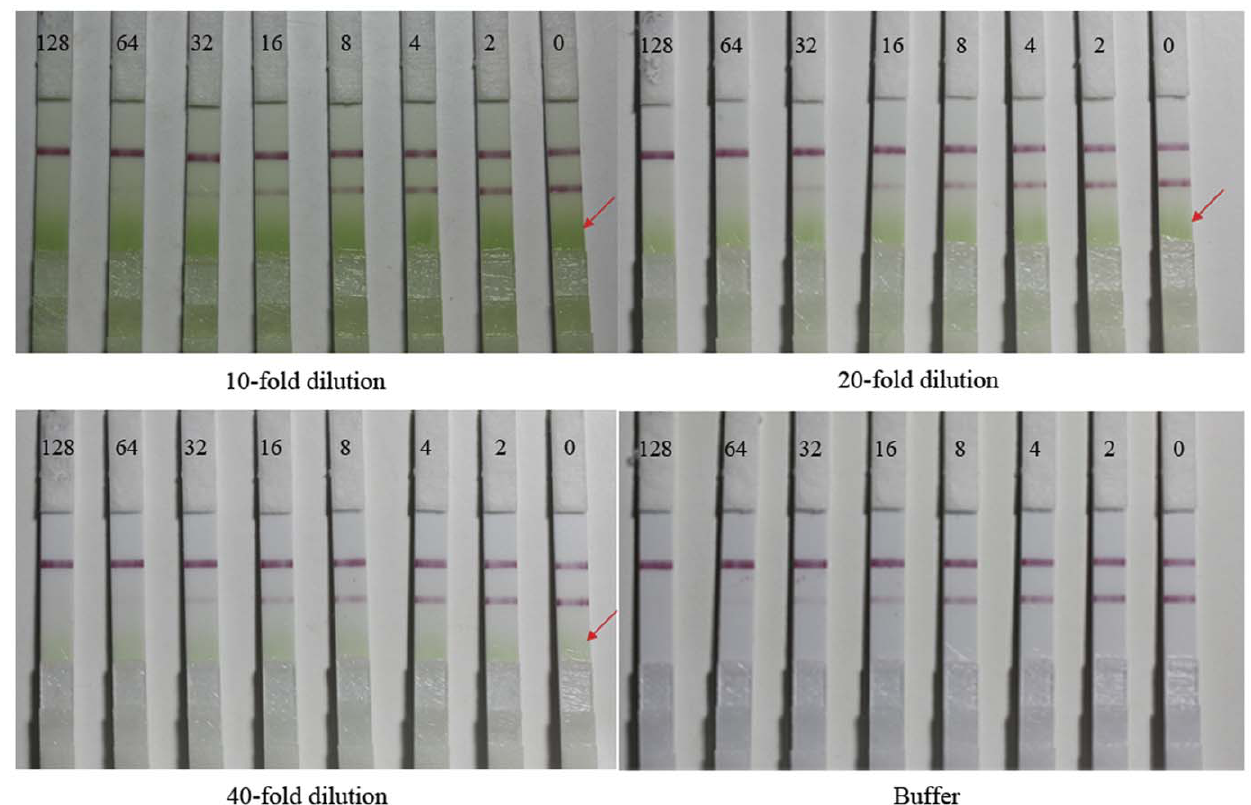
Figure 7. Matrix interference of greengrocery in ICA test strip. ICA test strip detection of parathion-methyl with 10-, 20-, 40-fold dilutions of greengrocery matrix interference and buffer. Standard solutions of parathion-methyl at each final concentration of 128, 64, 32, 16, 8, 4, 2 and 0 ng mL-1 (numbers across the top of strips from left to right) were tested. doi:10.1371/journal.pone.0053099.g007 Table 3. Recovery studies of samples spiked with parathion-methyl, parathion, and fenitrothion by multi-analyte ICA ( n =4).